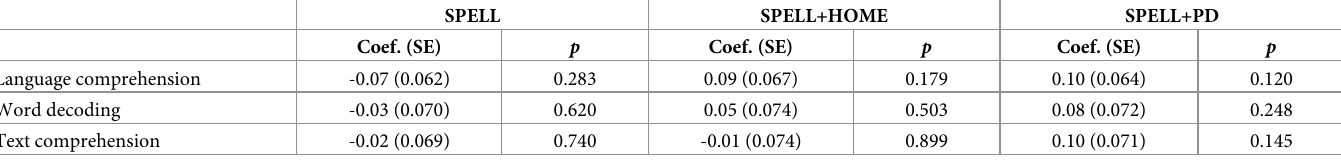
Table 4. Effect-size estimate on the three reading scores in second grade for the three SPELL conditions.